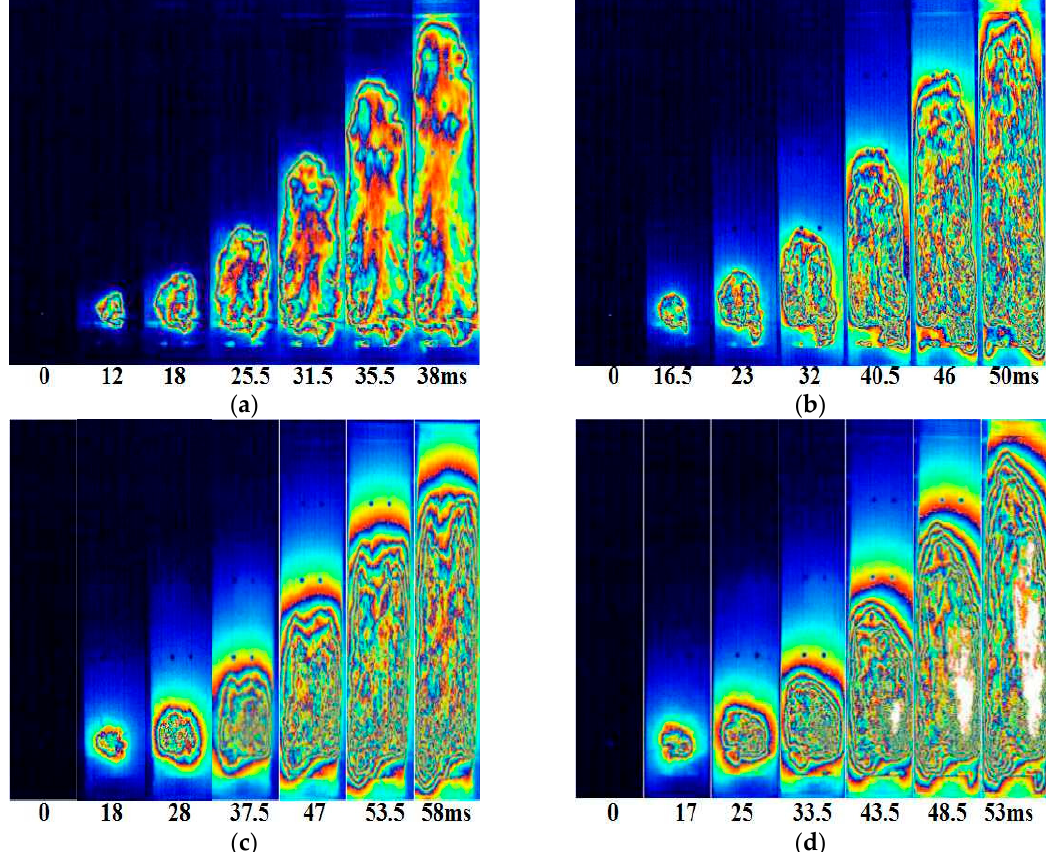
Figure 10. The flame propagating images of the 9.5% methane-air premixed gas explosion: ( a ) no powder; ( b ) with 0.16 g · L − 1 pristine palygorskite powders; ( c ) with 0.24 g · L − 1 pristine palygorskite powders; and ( d ) with 0.28 g · L − 1 pristine palygorskite